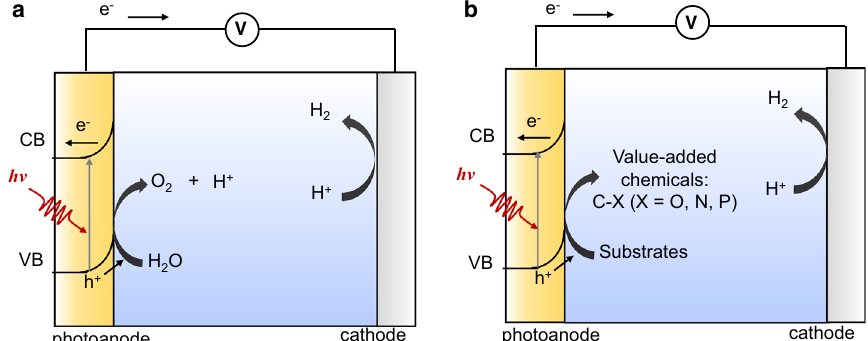
Fig. 1 PEC cells. a PEC water oxidation coupled with H 2 production. b PEC C – H functionalization coupled with H 2 production. CB conduction band, VB valence